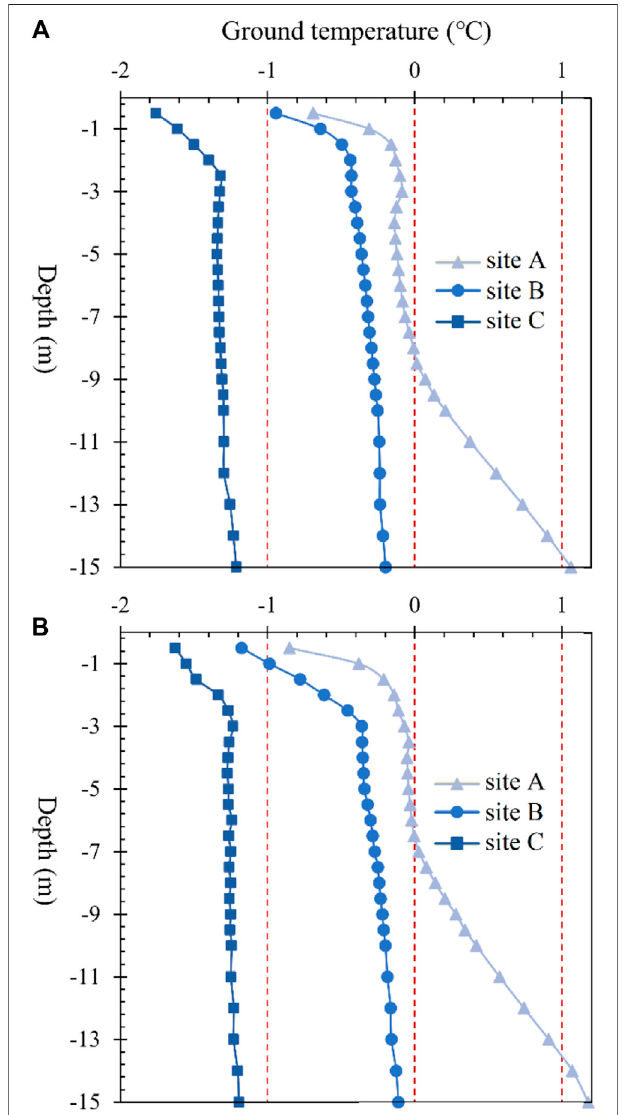
FIGURE5| Annualmeangroundtemperaturepro fi lesfor (A) 2013atthe three sites, and (B) 2020 at the three sites.